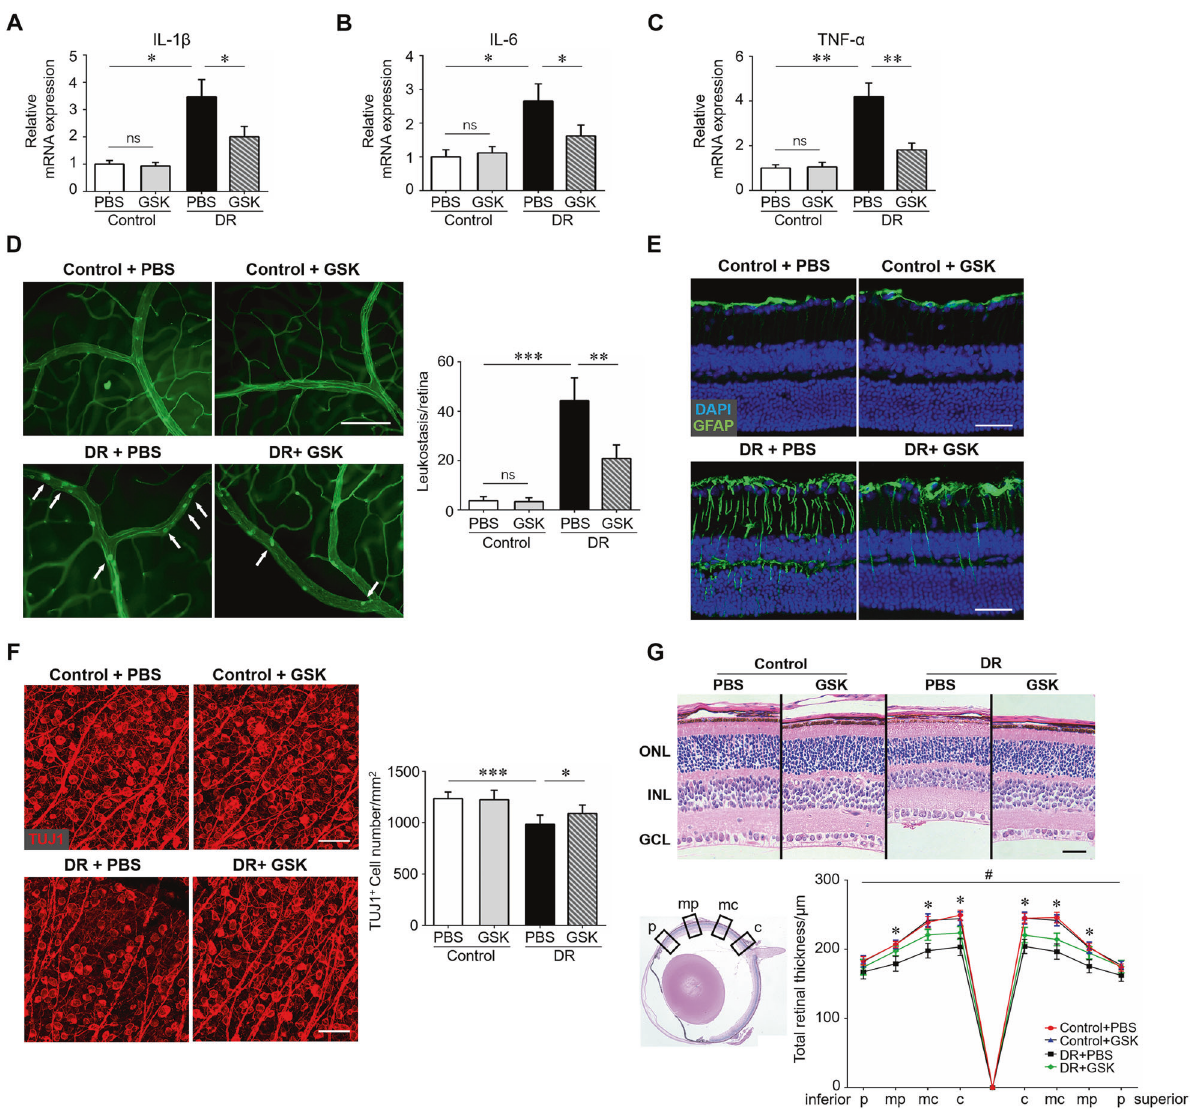
Fig. 4 RIP3 inhibition attenuated retinal neuroin fl ammation and neurodegeneration. Streptozotocin-induced diabetes model was established. Age-matched non-diabetes mice were used as control. GSK-872 or vehicle were injected intravitreally on the fi rst day of the 4th week and 8th week after STZ induction. Twelve weeks after diabetes induction, retina samples were collected and RNA was isolated using TRIzol Reagent. A – C qRT-PCR array was carried out for in fl ammation-related genes, including IL-1 β , IL-6, and TNF- α . D Retinal leukostasis was performed using fl uorescein-conjugated concanavalin A to label the adherent leukocytes. The number of adherent leukocytes were observed using a Leica microscope. Total adherent leukocytes per retina and six retinas from 6 mice in each group were used for analysis. Arrows indicated adherent leukocytes. Scale bar: 100 μ m. E Immunostaining of GFAP, a marker for astrocytes and Müller cells, on retinal cryosections. Scale bar: 100 μ m. F Immunostaining of TUJ1, a marker for neurons, on retinal fl at-mounts. Scale bar: 50 μ m. Three images were obtained in different locations of the retina (central, mid-peripheral and peripheral areas) and 6 retinas from 6 mice in each group were used for analysis. G H&E staining was carried out to evaluate retinal thickness in each group. Scale bar: 100 μ m. Retinal thickness at different locations, including central (c), mid-central (mc), mid-peripheral (mp), and peripheral (p), were analyzed. Three horizontal sections were randomly chosen and 6 eyes from 6 mice in each group were analyzed. *DR + PBS vs DR + GSK, P < 0.05. GSK, the speci fi c RIP3 inhibitor GSK-872. ONL outer nuclear layer, INL inner nuclear layer, GCL ganglion cell layer. Western blotting assays were repeated 3 times for statistical analysis. Data were shown as mean ± S.D. * P < 0.05, ** P < 0.01. *** P < 0.001, ns no signi fi